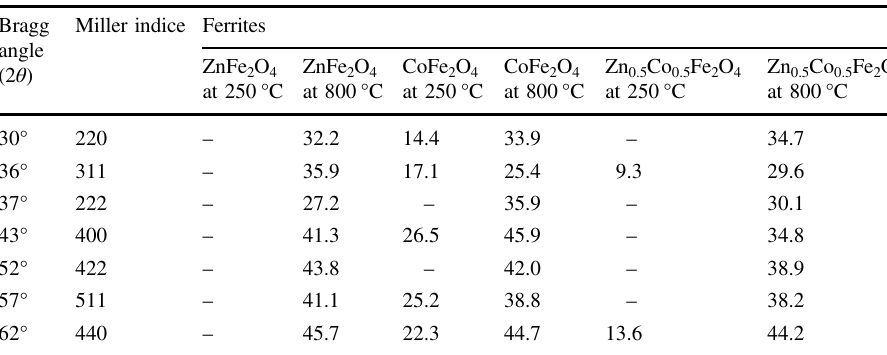
Crystallite size - Scherrer equation